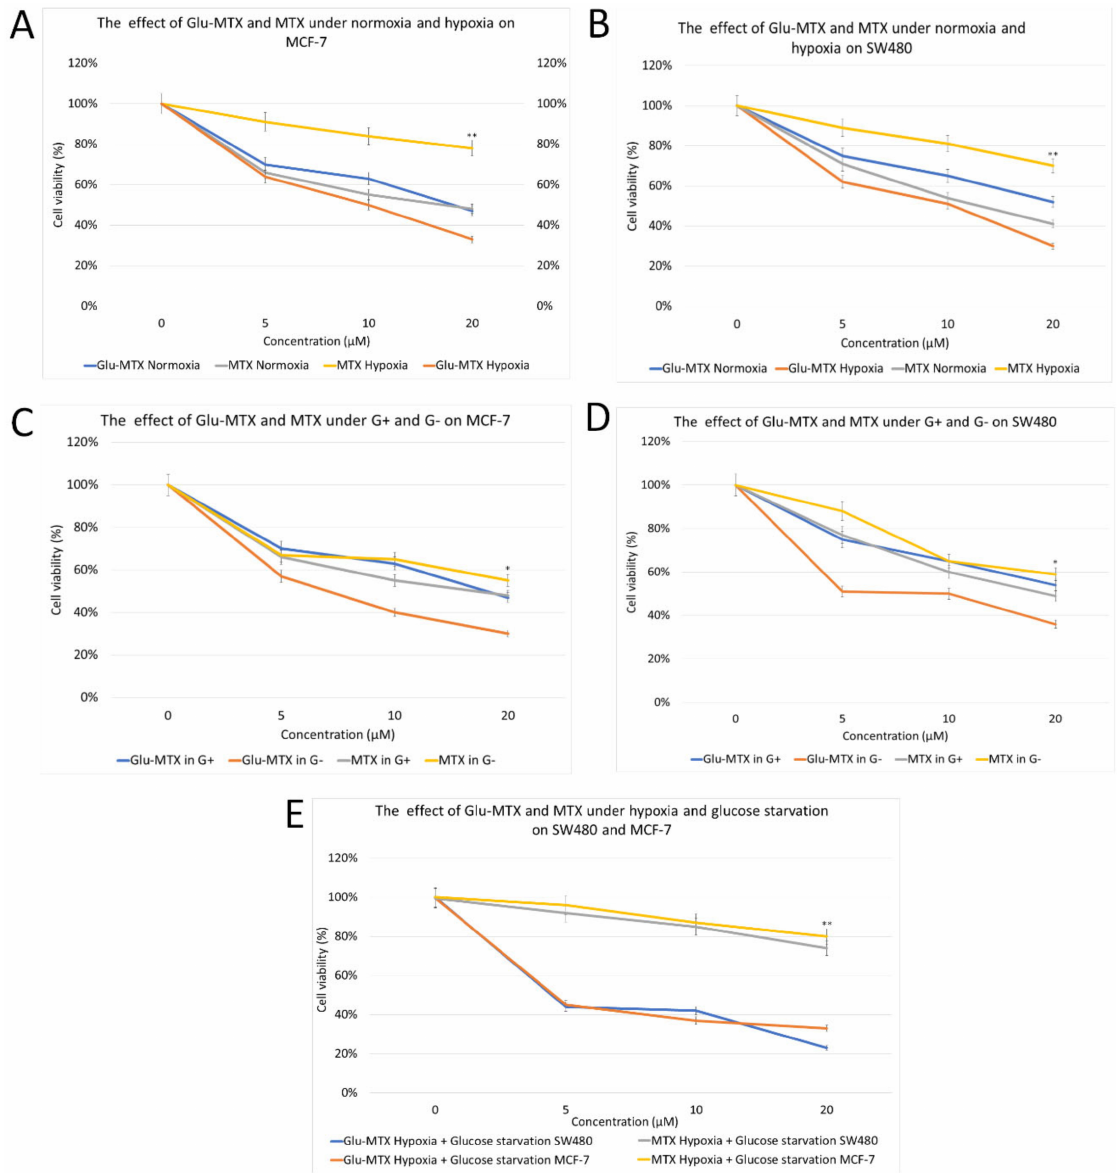
Figure 2. Results of cell viability after 48 h of incubation with 0, 5, 10, 20 µ M of MTX and Glu-MTX evaluated by MTT assay. ( A ) Dose-dependency curves for MCF-7 cells in normoxic (21% of oxygen, 5% CO 2 ) and hypoxic (1% of oxygen, 5% CO 2 ) conditions. ( B ) Dose-dependency curves for SW480 cells in normoxic (21% of oxygen, 5% CO 2 ) and hypoxic (1% of oxygen, 5% CO 2 ) conditions. ( C ) Dose-dependency curves for MCF-7 cells cultured in medium with glucose (G+) and glucose-free medium (G − ). ( D ) Dose-dependency curves for SW480 cells cultured in medium with glucose (G+) and glucose-free medium (G − ). ( E ) Dose-dependency curves for MCF-7 and SW480 cells in normal culture conditions (21% of oxygen, 5% CO 2 , G+) and in hypoxic (1% of oxygen, 5% CO 2 ) with glucose starvation conditions (G − ). Data are expressed as mean ± SD from triplicates. * p <0.05, ** p < 0.01, comparing Glu-MTX with MTX in hypoxia and/or glucose starvation